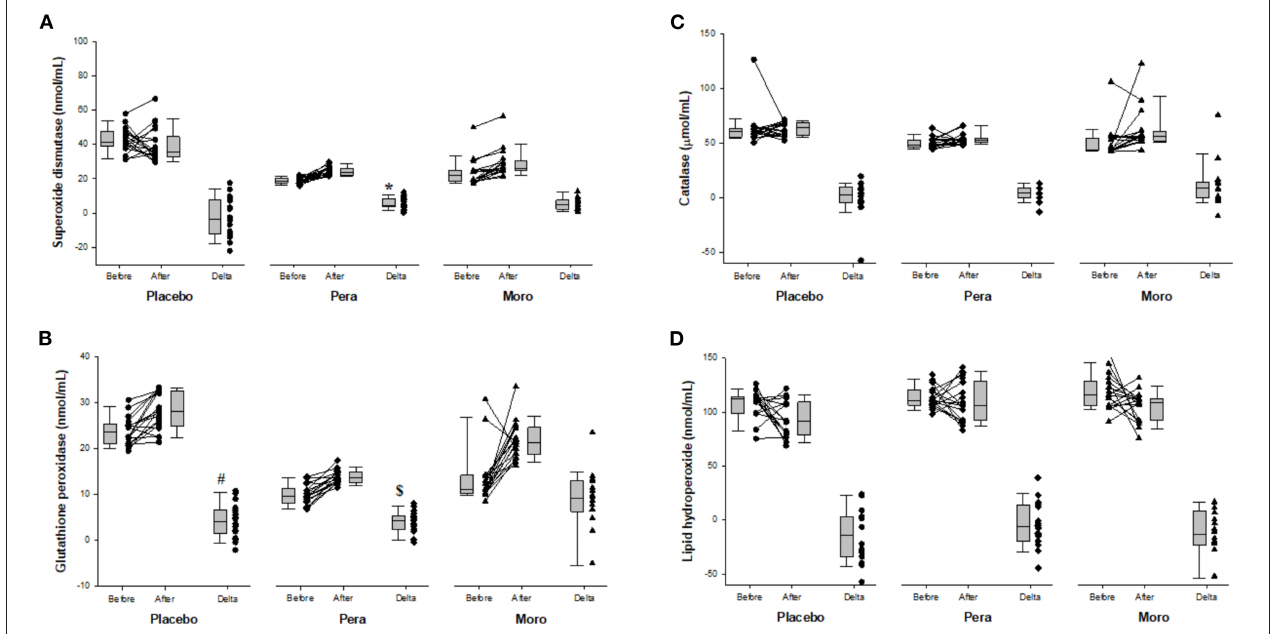
FIGURE 3 | (A) Comparison of serum superoxide dismutase between Placebo, “Pera,” and “Moro” groups ( n = 18 patients per group). The delta values of the three groups were compared using the Kruskal-Wallis test with Tukey’s post-hoc test ( p < 0.025). *Difference between “Pera” and Placebo groups. (B) Comparison of serum glutathione peroxidase between Placebo, “Pera,” and “Moro” groups. The delta values of the three groups were compared using the Kruskal-Wallis test with Tukey’s post-hoc test ( p = 0.004). # Difference between “Moro” and Placebo groups; $ difference between “Moro” and “Pera” groups. (C) Comparison of serum catalase between Placebo, “Pera,” and “Moro” groups. The delta values of the three groups were compared using the Kruskal-Wallis test ( p = 0.129). (D) Comparison of serum lipid hydroperoxide between Placebo, “Pera,” and “Moro” groups. The delta values of the three groups were compared using the Kruskal-Wallis test ( p = 0.313).